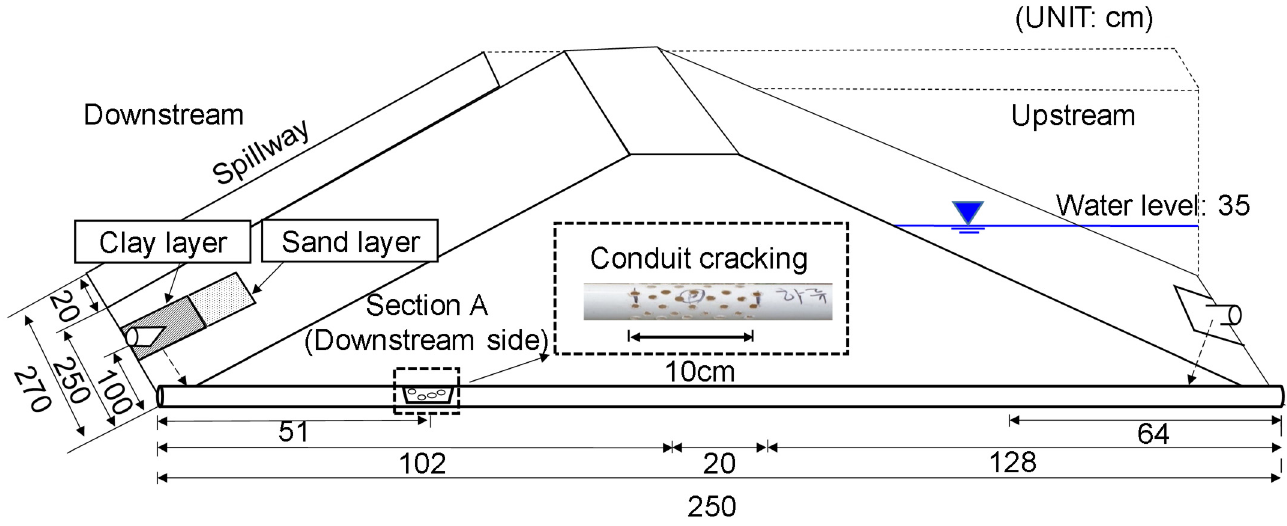
Figure 1. Experimental model and measurement location.